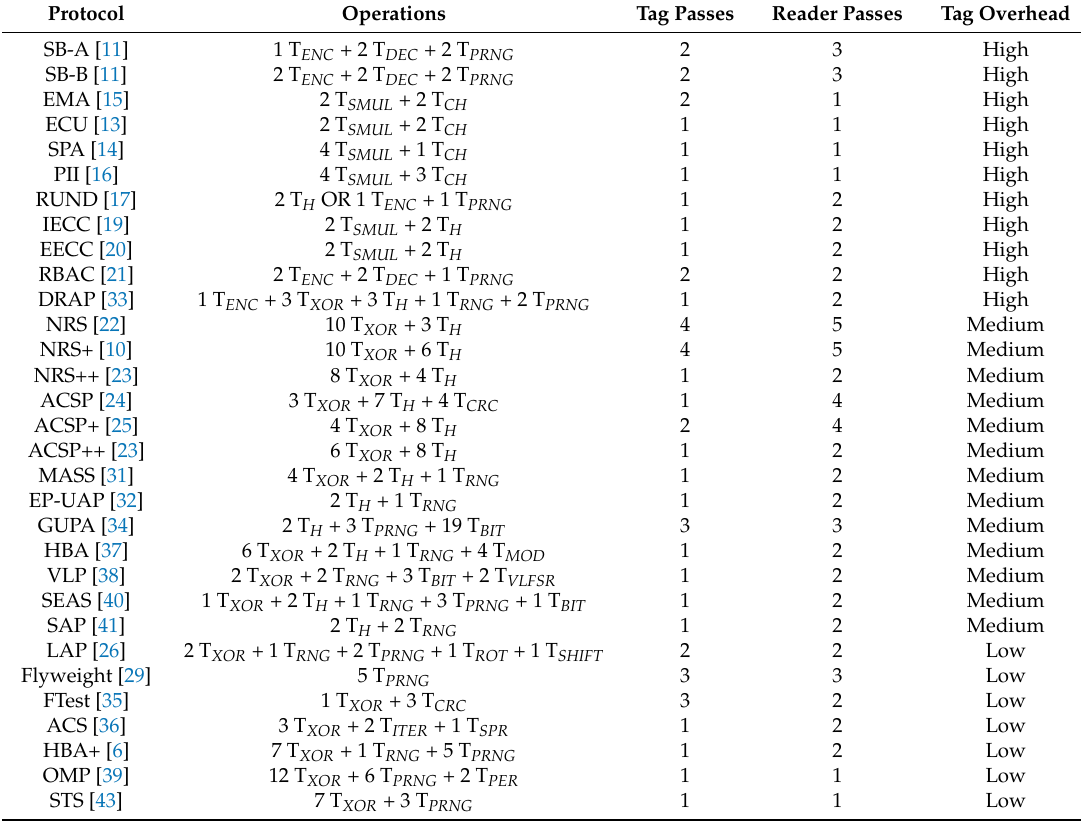
Table 2. Comparison of the Computation Cost on Tag.